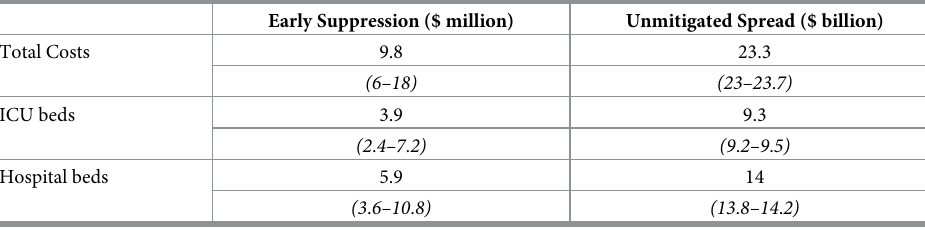
Table 3. Estimated hospitalization costs: Early versus unmitigated